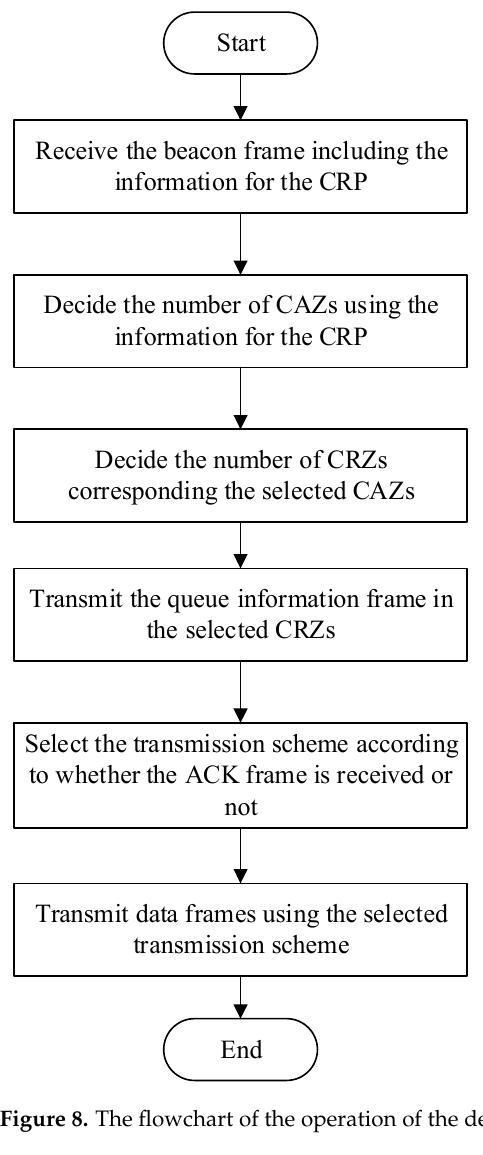
Figure 8. The flowchart of the operation of the device in the proposed